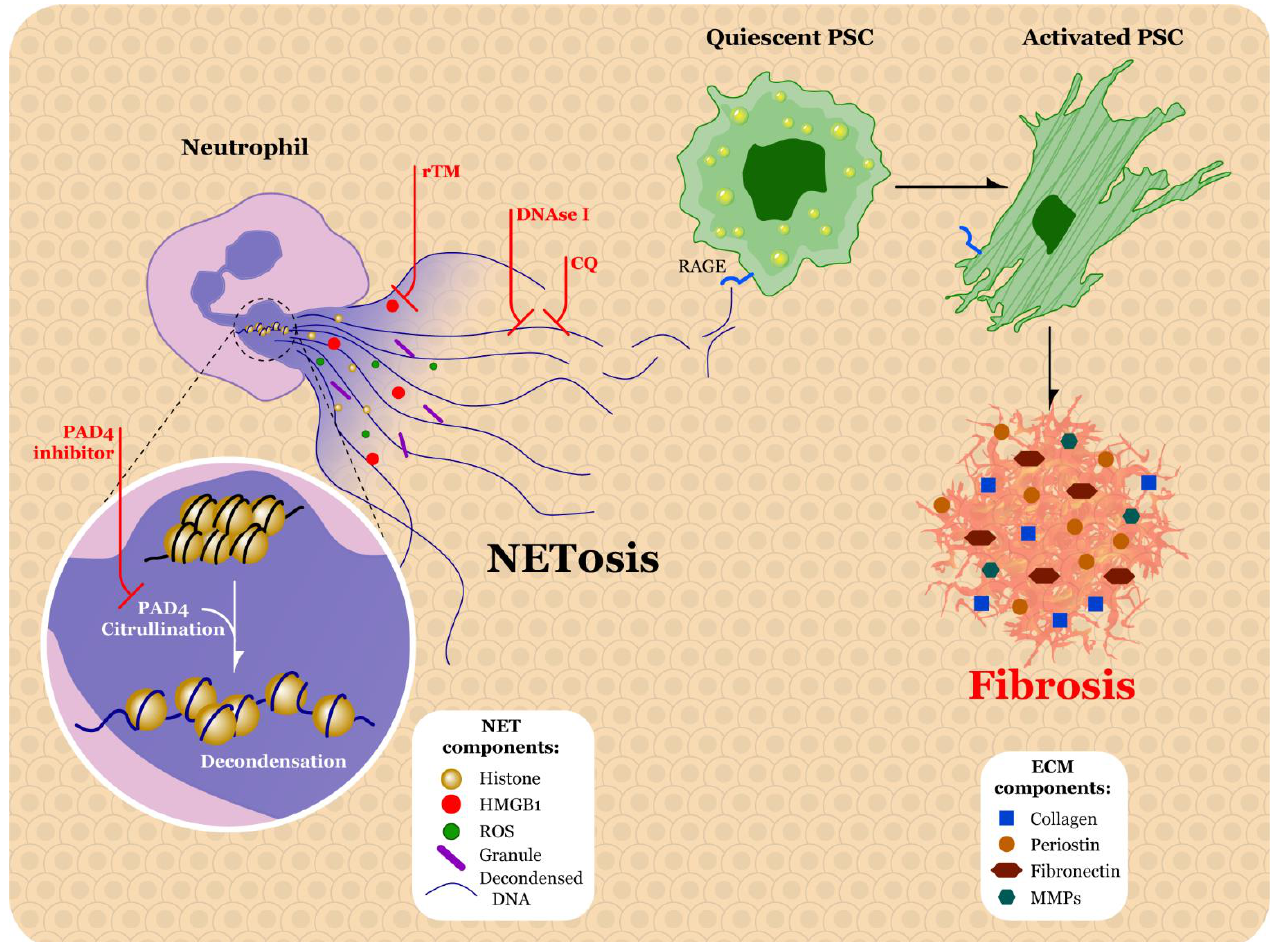
Figure 3. Proposed neutrophil extracellular trap (NET) targeting strategies. Peptidyl arginine deiminase 4 (PAD4) inhibitors block PAD4-mediated citrullination of histones, thereby preventing heterochromatin decondensation and subsequent NET release. Recombinant thrombomodulin (rTM) can inhibit high mobility group box 1 protein (HMGB1), reducing capture and migration of tumor cells by NETs. DNAse I and chloroquine (CQ) degrade and decrease secretion of decondensed DNA, respectively, thereby reducing interactions of decondensed DNA with the receptor for advanced glycation end products (RAGE), preventing pancreatic stellate cell (PSC) activation and subsequent extracellular matrix (ECM) deposition. ROS, reactive oxygen species; MMPs, matrix metalloproteinases.